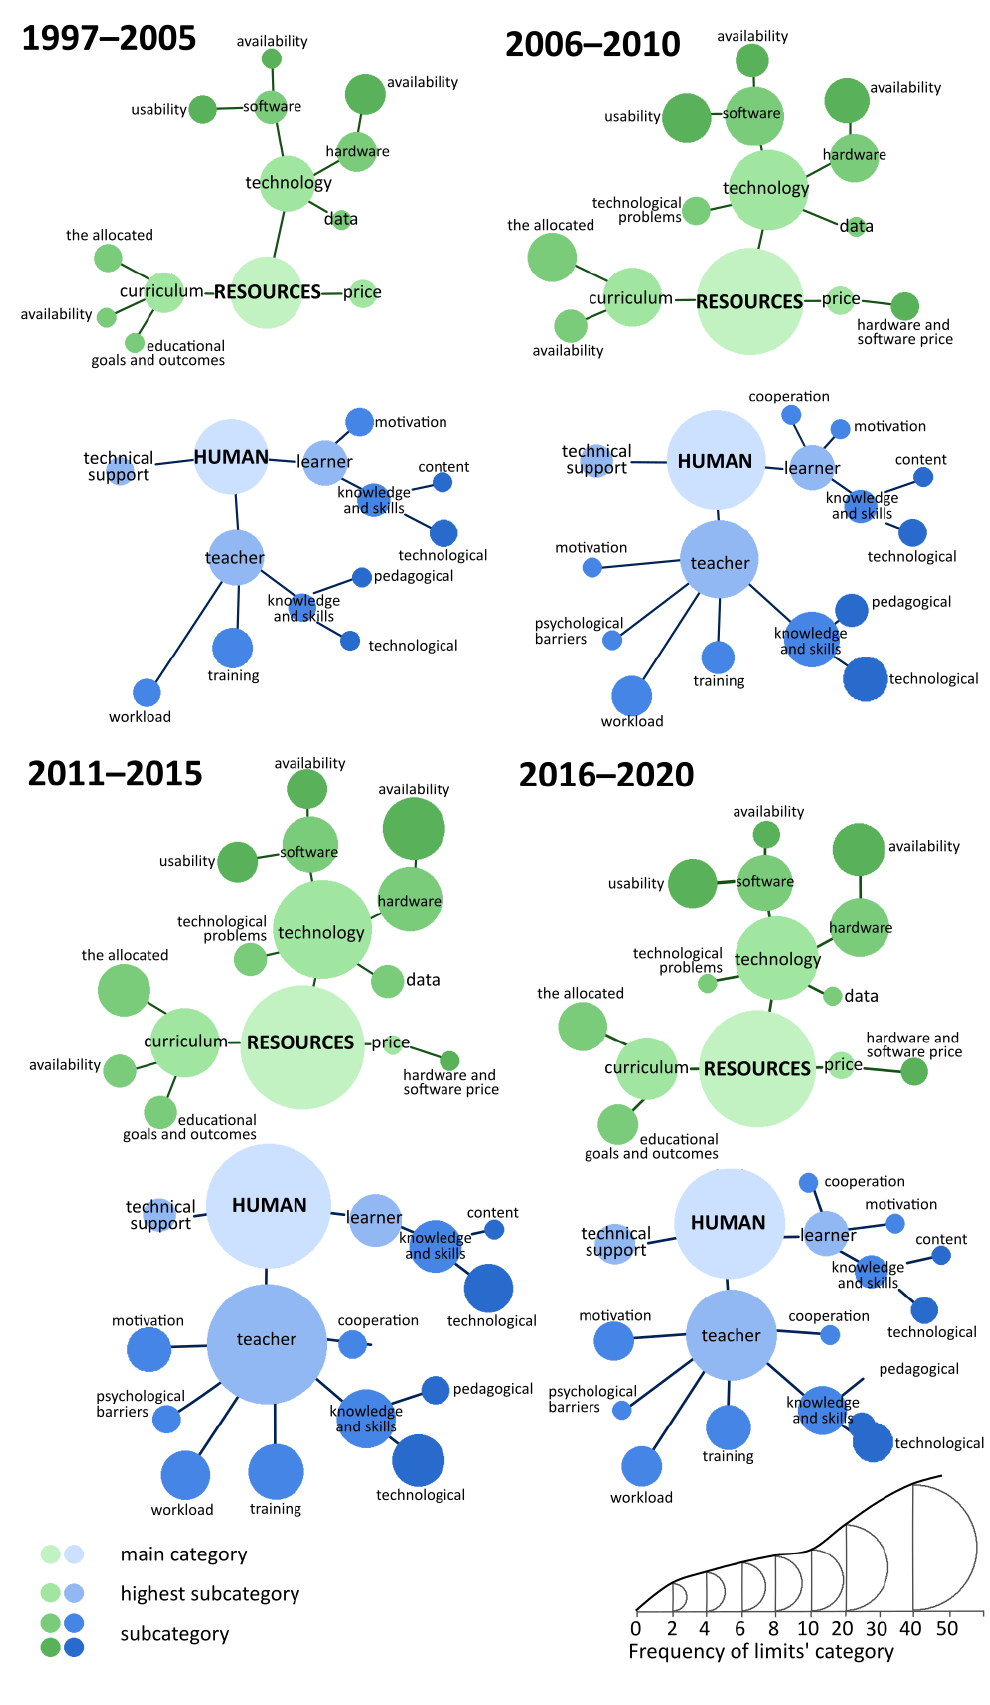
Figure 7. Temporal trends in the frequency of the identified limits’ categories.